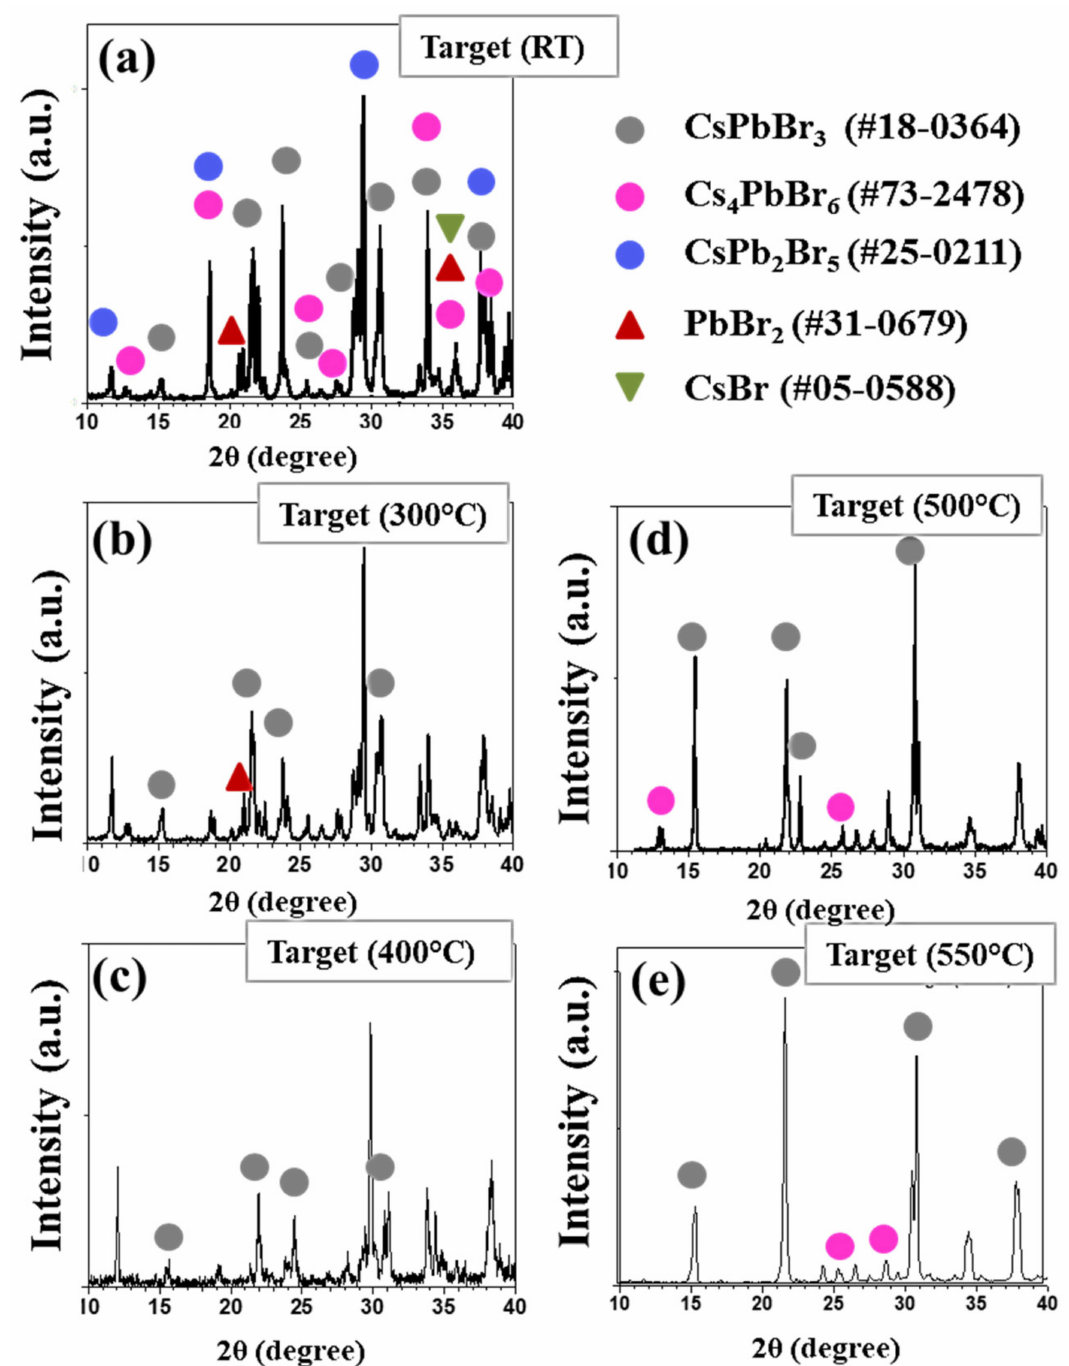
Figure 4. XRD spectra of the mechano-chemically synthesized targets under different heating treatments, that is ( a ) room temperature, ( b ) 300 ◦ C, ( c ) 400 ◦ C, ( d ) 500 ◦ C and ( e ) 550 ◦